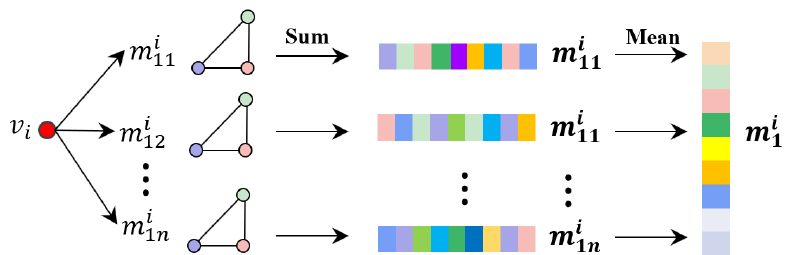
represents the triangular 1 j and m i represent the motif embedding of m i and triangular 1 1j 1 j